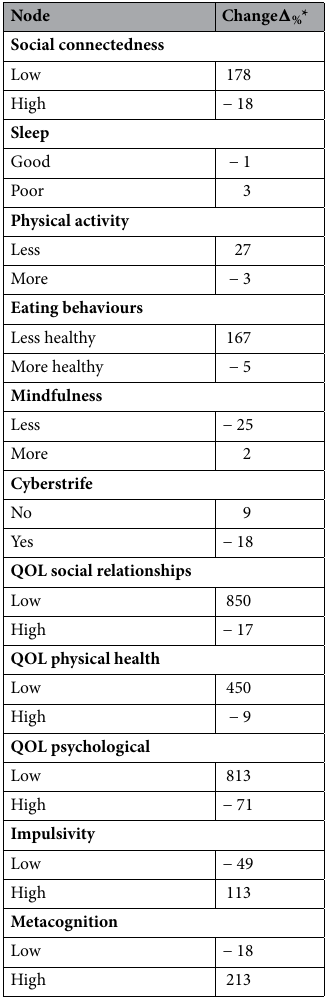
Table 4. Scenario 2 ‘certainty for severe psychological distress’, displaying changes propagated in Bayesian network with query constraint of severe psychological distress. * (cid:31) % =